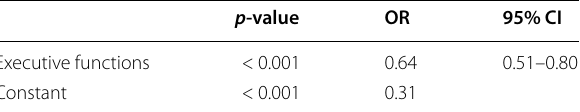
Table 5 Logistic regression predicting likelihood of an inactive occupational status (cognitive and clinical factors as